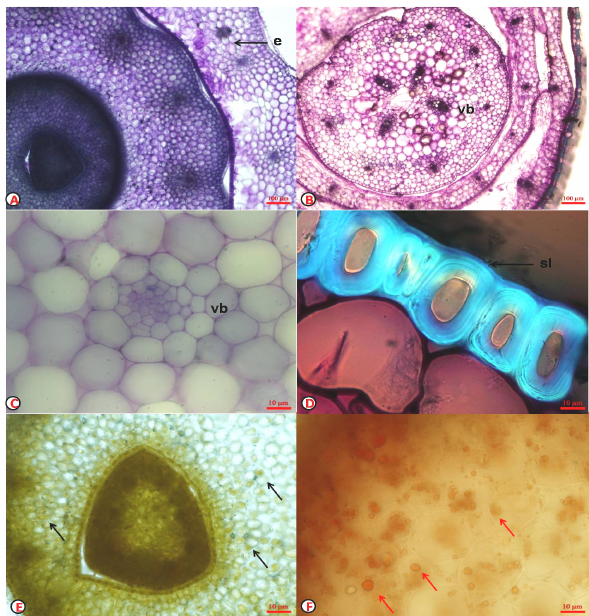
Fig. 7. Transversal sections of Allium strachey root: A) T.S. of root showing stele, cortex and epidermis; B. T.S of stele region; C) Presence of alkaloid (black arrow) in cortical cells; D) Presence of lipid droplets (red arrow) in cortical cells; co - cortex; e - epidermis; en - endodermis; mx - metaxylem; p - pith; px -